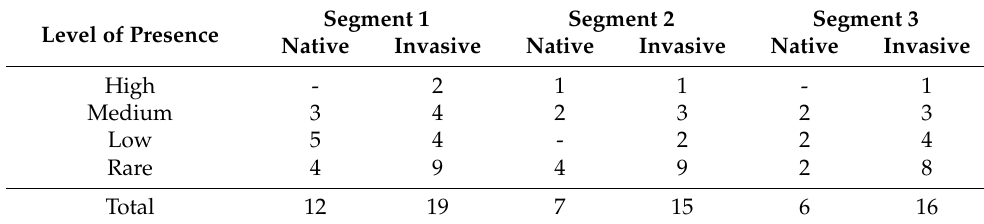
Table 6. Total of native and introduced species by segment of analysis according to level of presence.